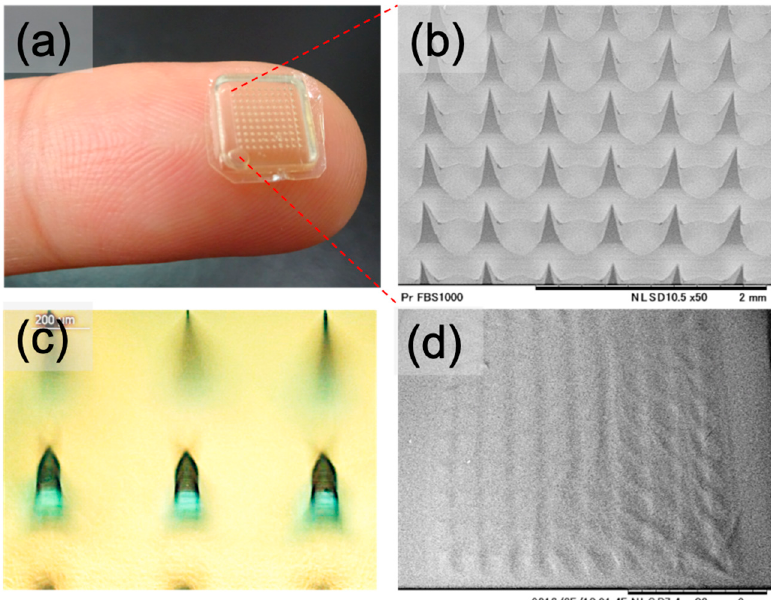
Figure 2. Characteristics of a gelatin microneedle patch. ( a ) The size and shape of the microneedle patch on the fingertip; ( b ) SEM image of microneedle patch with shape 10 × 10 array, around 500 µ m needle length, with a total area of 64 mm 2 ; ( c ) microneedles with FITC-fluorescent dye loading; and ( d ) the morphology of microneedle tips after placing on the surface of PBS for 3 min.